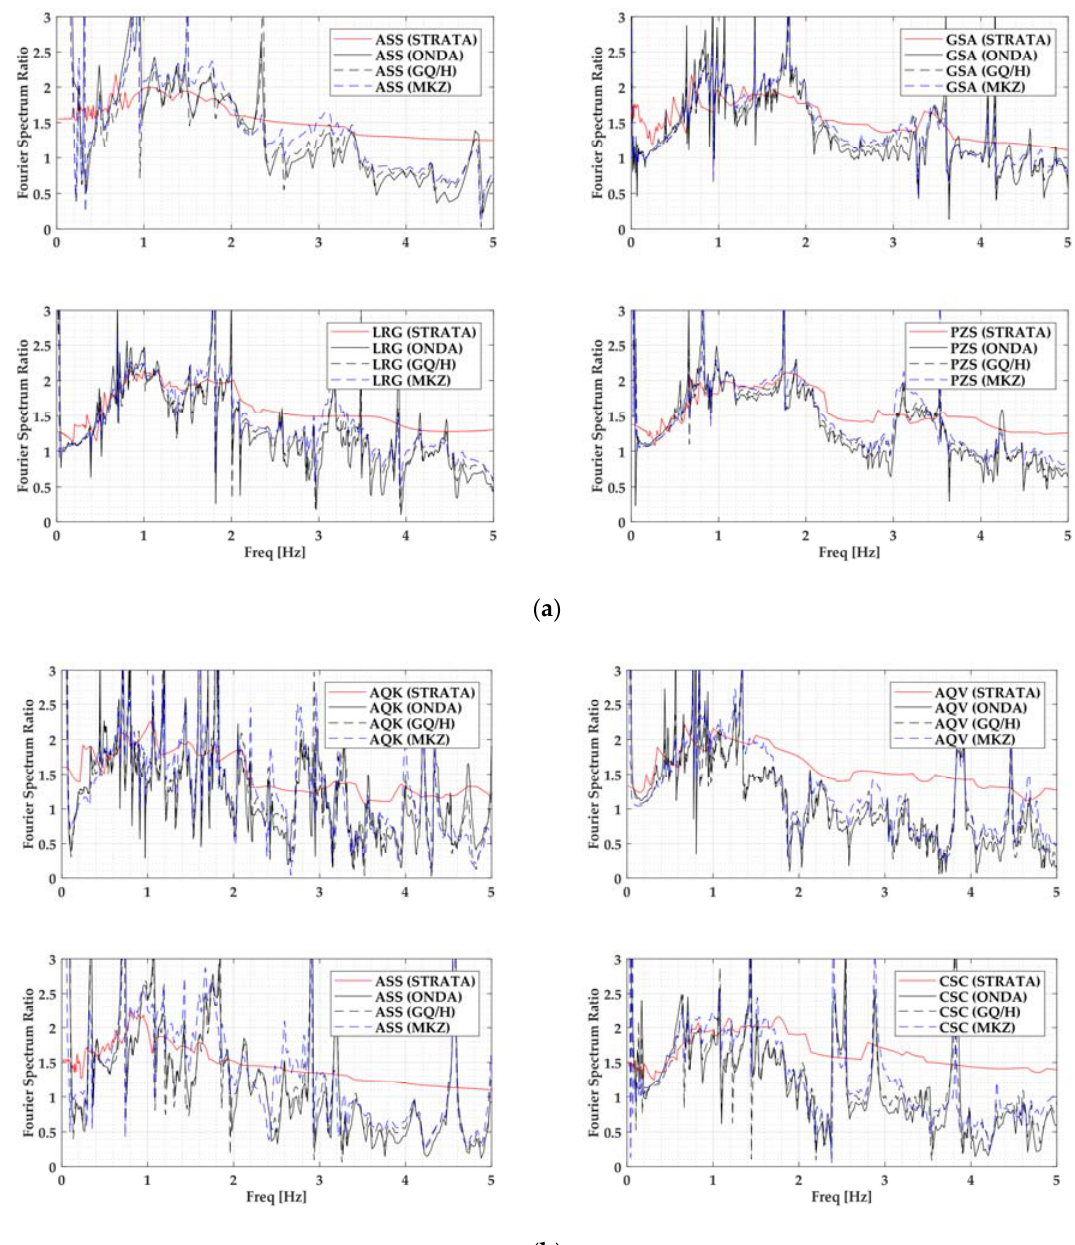
Figure 15. Fourier spectrum ratios between the surface and the base of the soil profile for some relevant input motions: ( a ) return period = 130 years; ( b ) return period = 500 years.